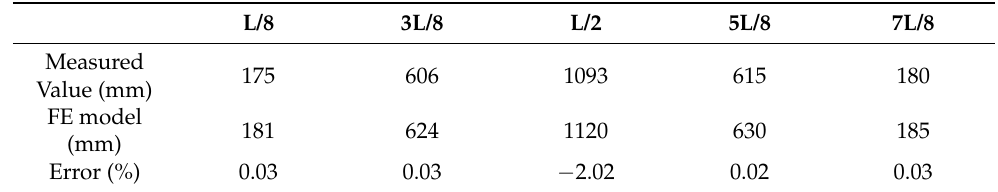
Figure 6. Load case of bridge static and running tests. (unit: m)